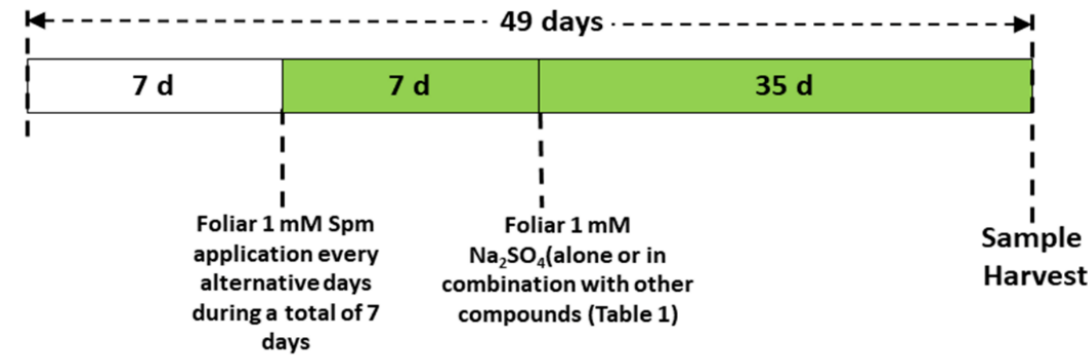
Figure 1. Scheme of the foliar treatments used to study the effects on wheat plants grown in the presence of 1 mM Na 2 SeO 4